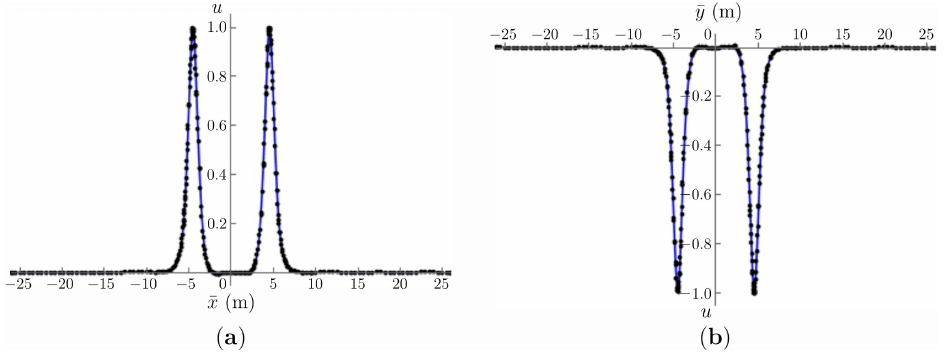
Figure 7. Same as in Figure 6, but determined for q = 10. The displacements are evaluated ( a ) in the direction ¯ x and ( b ) along the perpendicular direction ¯ y .